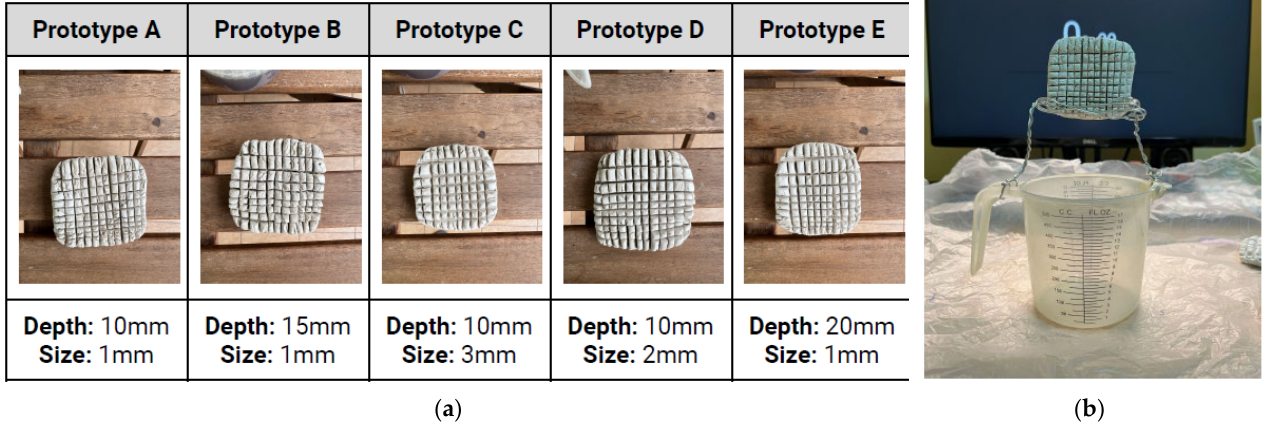
Figure 3. ( a ) Prototypes A to E were made from clay showing different depth and width of the gaps representing elephant skin texture. ( b ) Experimental procedure to test water retention capacity. Pho- tos: [24].